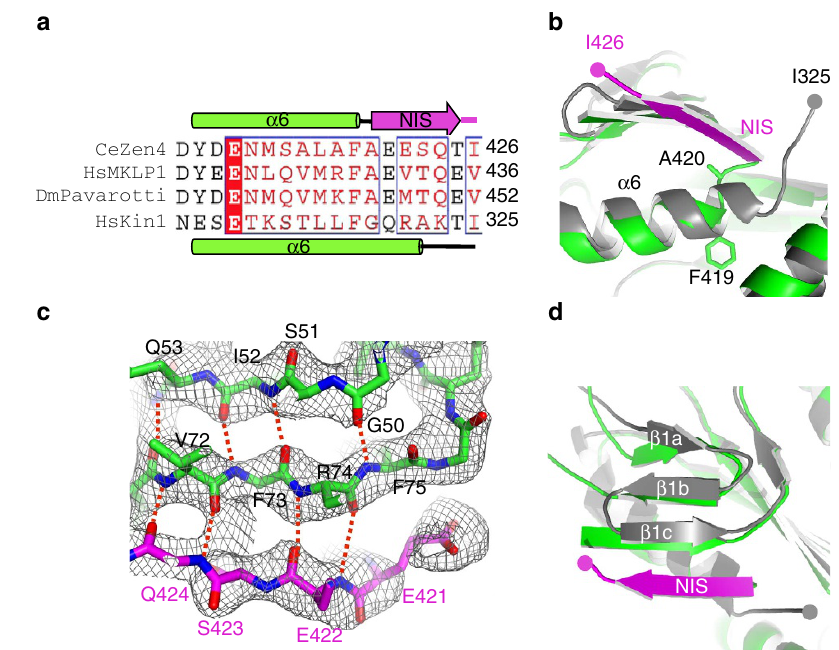
Figure 2 | Unwound a 6 and backward-docked NIS of Zen4 in the apo state. ( a ) Sequence alignments around the NIS region of three kinesin-6 family proteins and human kinesin-1 (HsKin1). The secondary structure assignments on the top and at the bottom are based on the structures of Zen4 and kinesin-1 (PDB code 1BG2), respectively. ( b ) Superimposition of the structure of Zen4 with that of kinesin-1 in the ADP-bound state, showing region around the a 6 helix. The alignment was done as in Fig. 1c. The grey and magenta dots indicate the last ordered residue at the C termini of kinein-1 and Zen4, respectively. ( c ) Superimposition of the structure of Zen4 around the NIS with the 2Fo-Fc map at contour level of s ¼ 1. ( d ) Superimposition of the structure of Zen4 with that of kinesin-1 around the N-terminal appending b